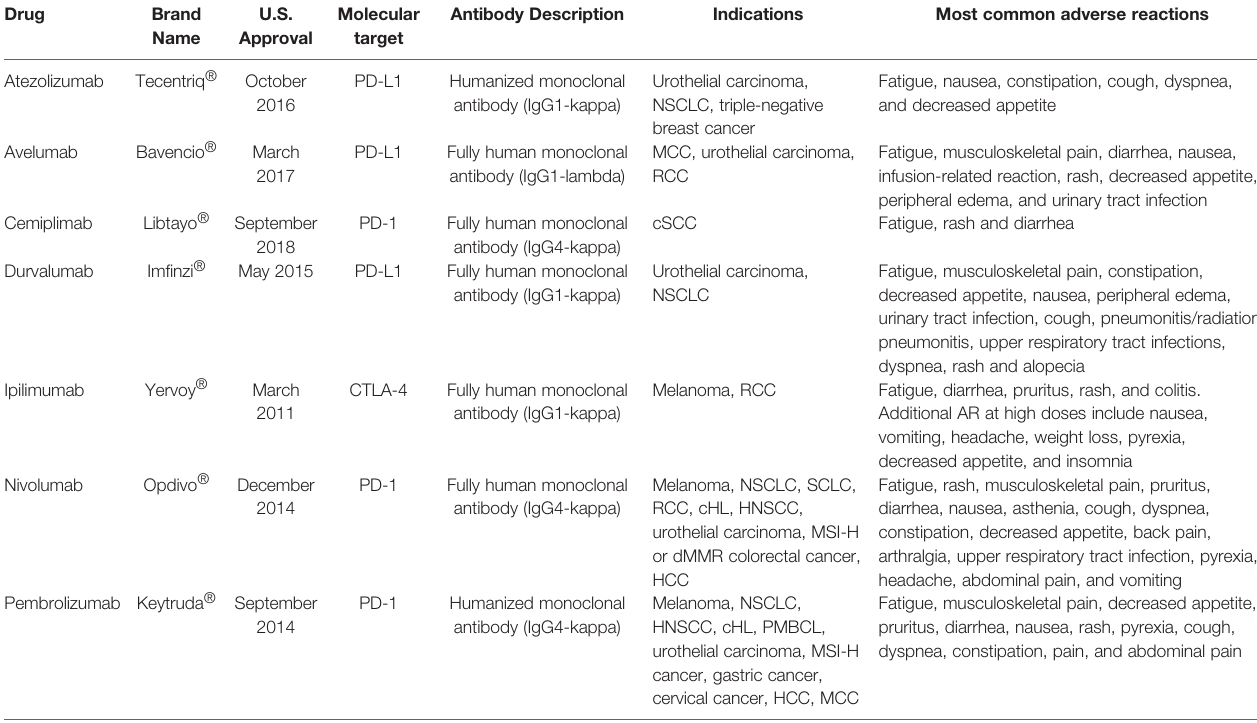
TABLE 1 | FDA-approved immune checkpoint